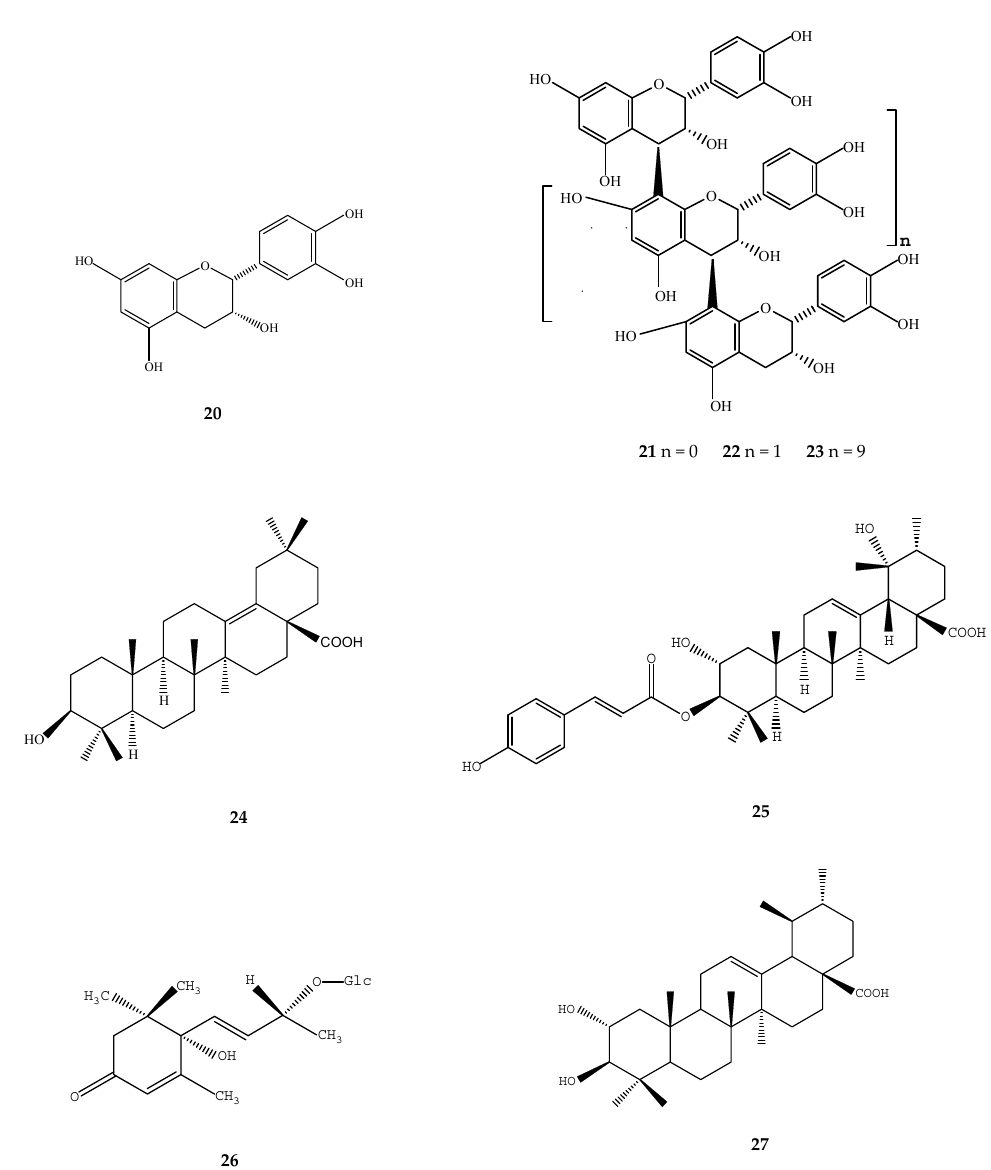
Figure 3. Structures of chemical compounds 20 – 27 . 20 : epicatechin; 21 : procyanidin B-2; 22 : procyanidin C-1; 23 : procyanidin oligomer; 24 : δ -oleanolic acid; 25 : 3- O -( E )- p -coumaroyl tormentic acid; 26 : roseoside; 27 : 2 α -hydroxyursolic acid.